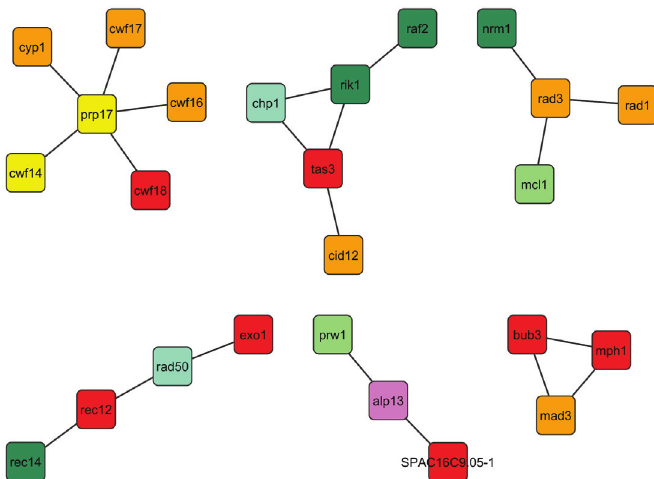
Figure S2. S. pombe UBA1 primary gene interaction network. Fission yeast epistatic modifiers from all four SGA datasets were combined and used to map a protein-protein interaction network using the highest confidence protein interaction data (STRING-db).